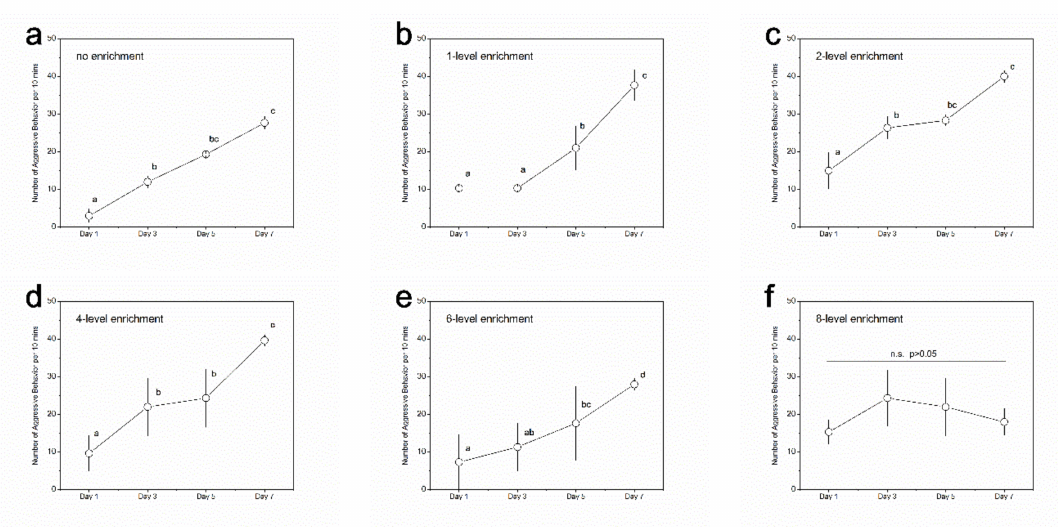
Figure 5. Level of aggressive behavior in fat greenling among experimental days within a specific treatment group. ( a ) No enrichment group; ( b ) 1-level enrichment group; ( c ) 2-level enrichment group; ( d ) 4-level enrichment group; ( e ) 6-level enrichment group; ( f ) 8-level enrichment group. Different letters indicate significant differences among experimental days within a specific treatment group. n.s. indicates no significant difference. n = 3. Data are presented as means ±